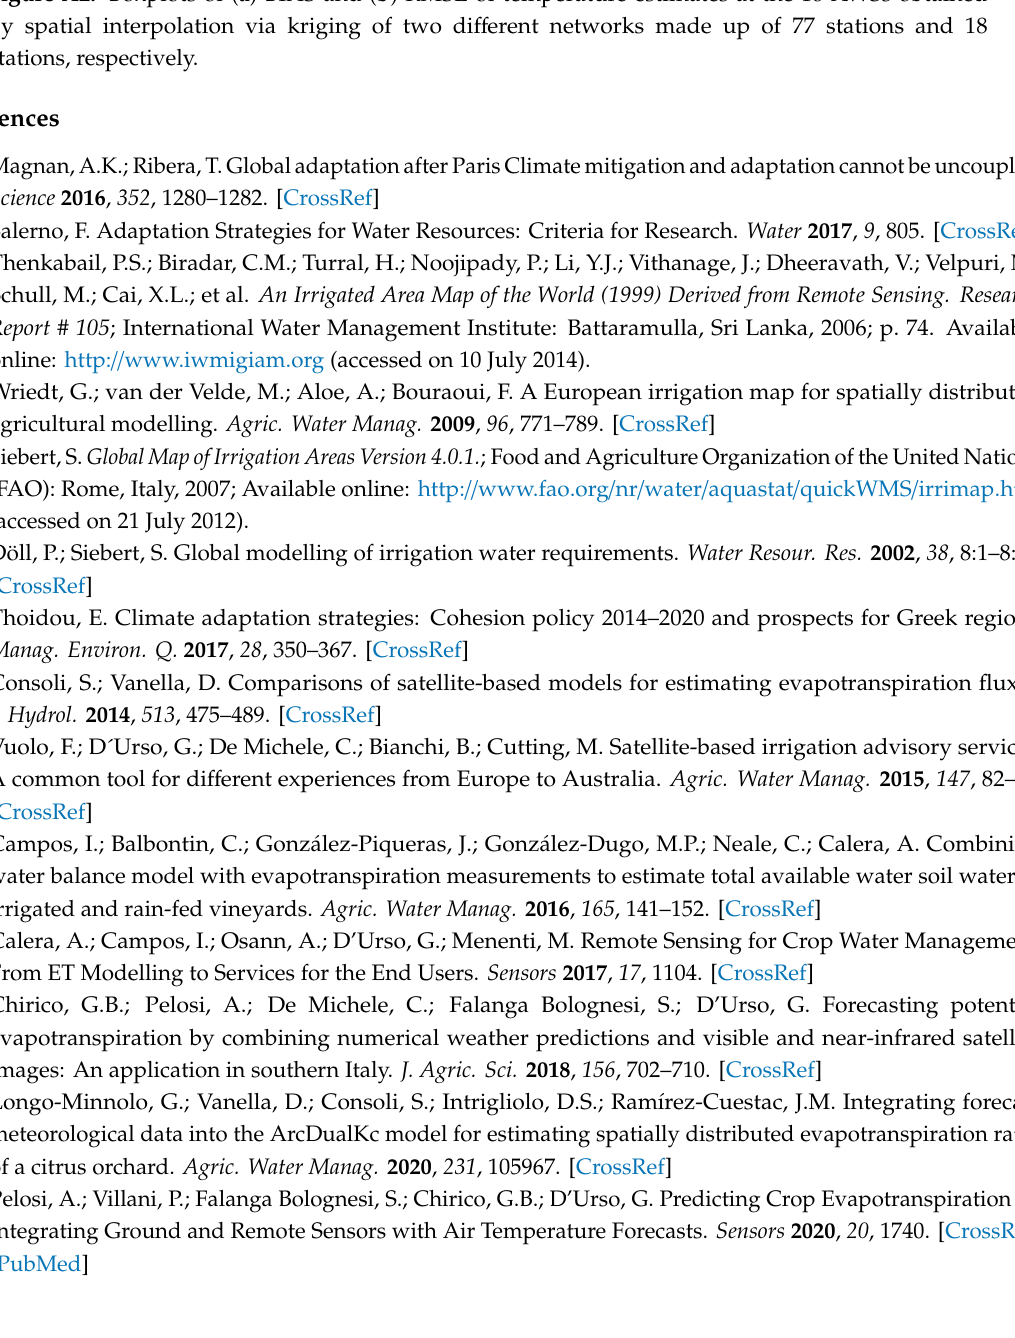
Figure A2. Boxplots of ( a ) BIAS and ( b ) RMSE of temperature estimates at the 18 AWSs obtained by spatial interpolation via kriging of two di ff erent networks made up of 77 stations and 18 stations, respectively.